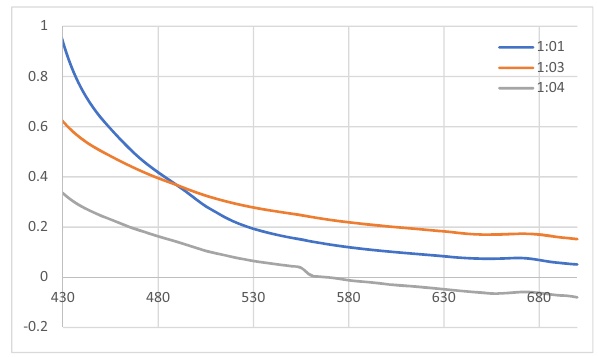
Figure 1: UV spectra of the AgNPs solution with methanolic extract of Tropaeolum majus